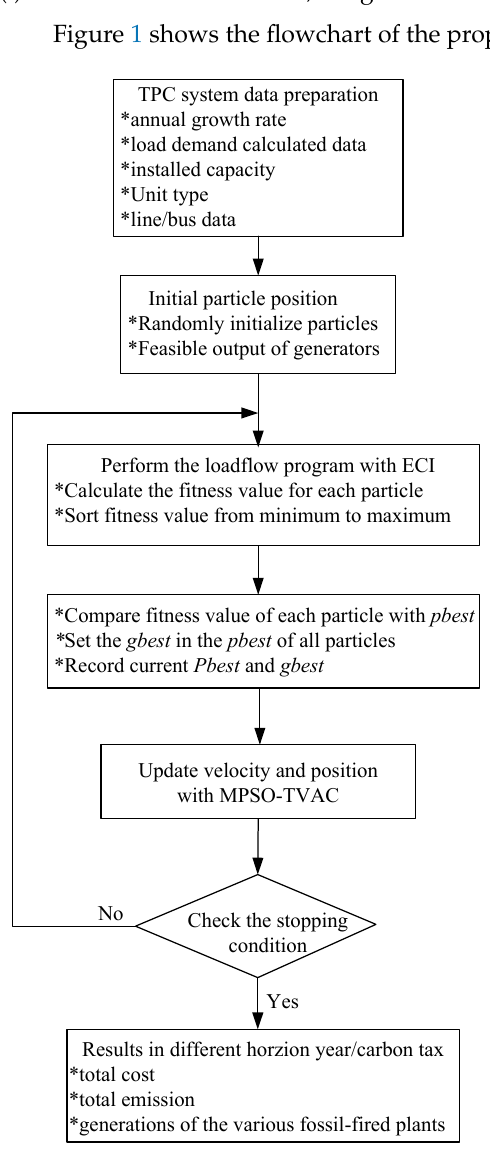
Figure 1. Flowchart of the proposed methodology.